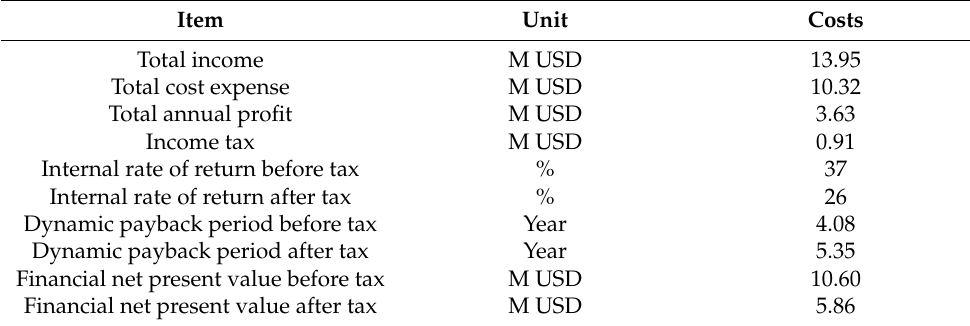
Table 7. Financial evaluation index of OPTS 10,000 tons fuel ethanol per year project.